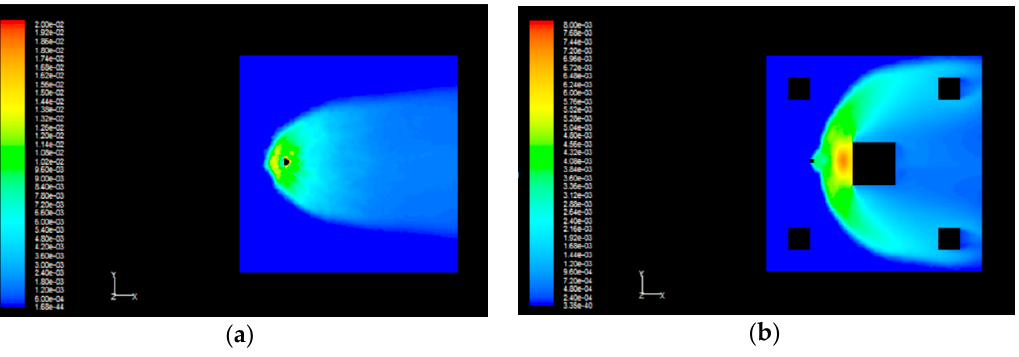
Figure 3. ( a ) The diagram of gas diffusion without the influence of buildings; ( b ) The diagram of gas diffusion with the influence of buildings.